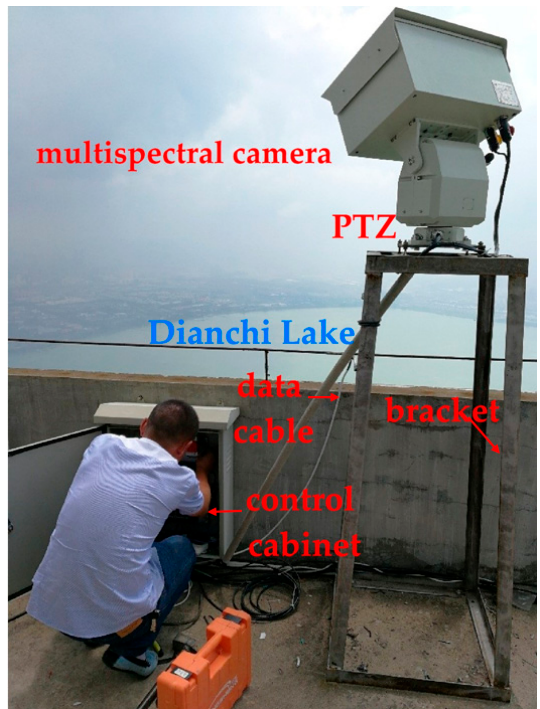
Figure 2. Multispectral camera with the pan–tilt–zoom (PTZ) and bracket installed at the Dianchi Lake monitoring site. Lake monitoring